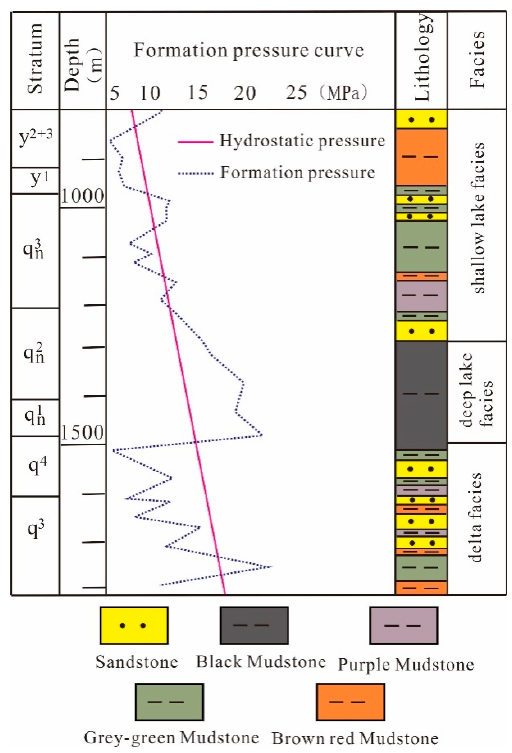
Figure 8. Formation pressure characteristics of the Xin171 well.